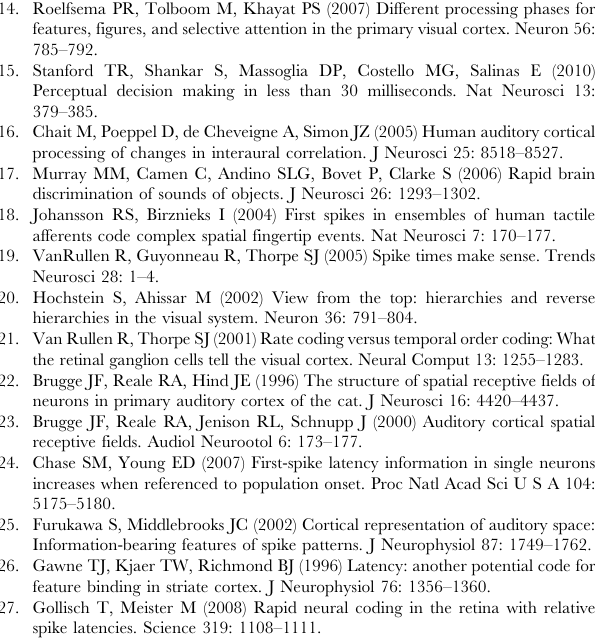
data (Pc(original)-Pc(shuffled)) for each pair of columns on the left. Although the performance is typically better in the original correlated data, the overall size of the effect is relatively small, on the order of 1%. For small populations, the correlations increase tWTA accuracy. However, as the population size increases, this difference decays to zero. The simplified model (H) captures the behavior of the data (see Text S1). Figure S5 Effect of different definitions of response latency. Gawne et al. [26] recorded responses to oriented bars in V1 of behaving monkeys and reported that the effect of stimulus orientation on response latency is relatively weak. The difference with our results can be attributed to different definitions of response latency. Gawne et al. defined response latency to be the time at which the PSTH reaches its half peak (in cases where the peak was less than twice the spontaneous activity, latency was left undefined). We used the cumulative distribution function of first spike times and defined the first spike latency tuning curve as a level curve of this distribution. (A–C) First-spike latency tuning curves as computed by first spike (cumulative) distribution level curves (red) and the corresponding latency tuning curves for the same cells using the time at which the PSTH reaches half of its peak (black). (Lower and upper error bars for the halfmax definition were calculated using the times at which the PSTH reaches half the peak of the PSTH minus and plus its standard error of the mean). B denotes the modulation amplitude using our latency definition and B 9 using the half max definition. For the cells in (A) and (B), the latency tuning curve using the half max definition (black) is relatively flat, whereas the first spike latency tuning curve using our definition (red) shows a strong modulation. For the cell in (C) both definitions show pronounced tuning. (D) Scatter plot of the modulation amplitudes, B and B 9 , for each cell. Notably, the tuning amplitudes using the halfmax definition are relatively small, whereas our definition results in many cells with significant modulation.